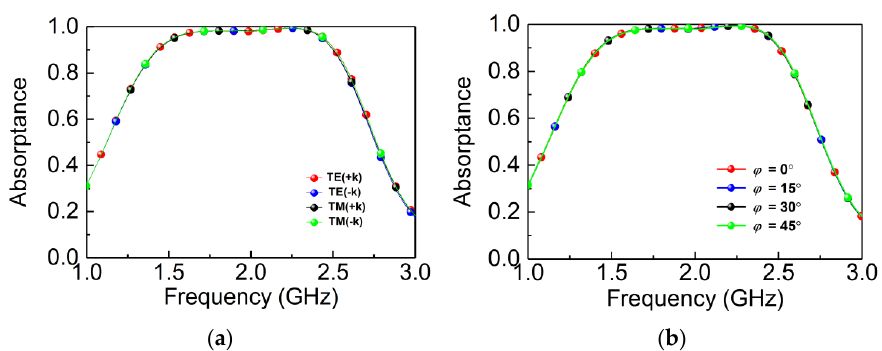
Figure 2. Absorptance with different polarization angles. ( a ) Forward and backward absorptance in TE and TM mode; ( b ) absorptance at different polarization angles. +k represents the EM wave along the + z direction, and − k represents the EM wave along − z direction.